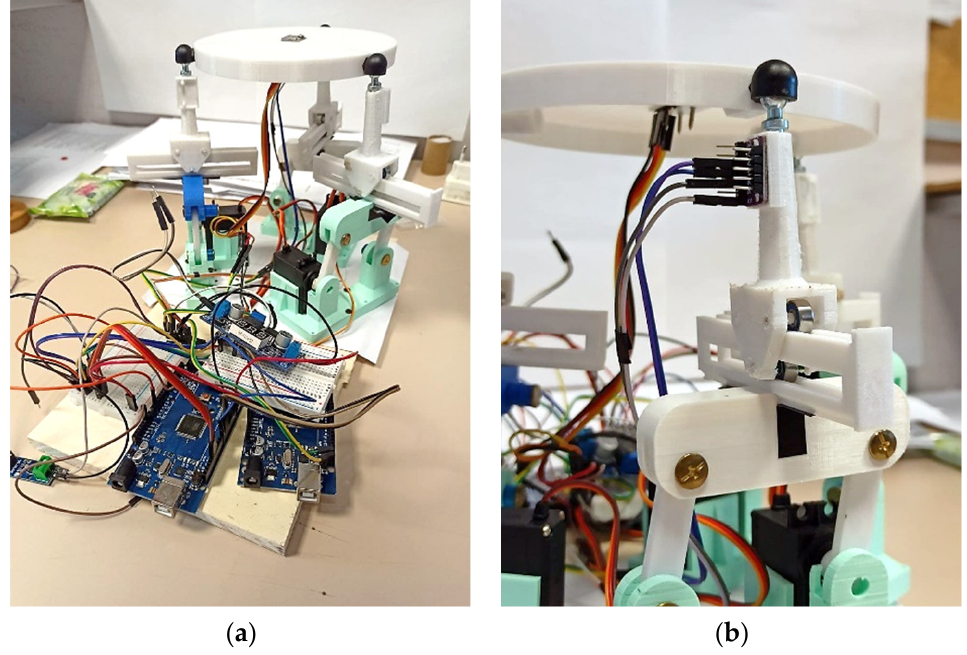
Figure 8. ( a ) The lab assembly of the new prototype L-CaPaMan2 in Figure 3; ( b ) mechanical design of the new translational joint in L-CaPaMan2.